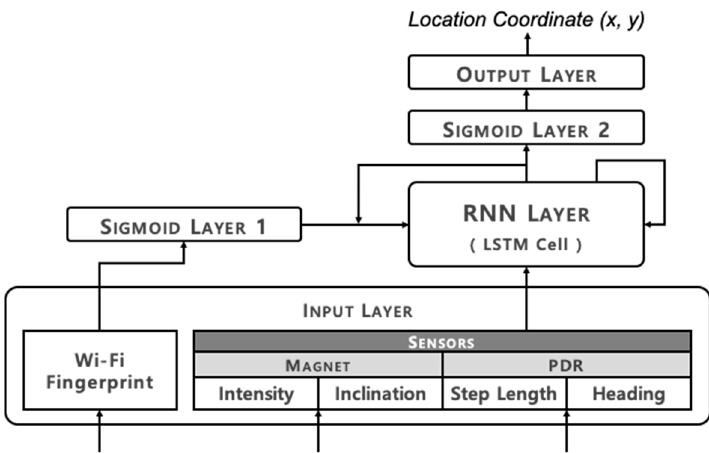
Figure 5. Structure of the recurrent neural network (RNN)-based hybrid localization system (RHLS) positioning module.